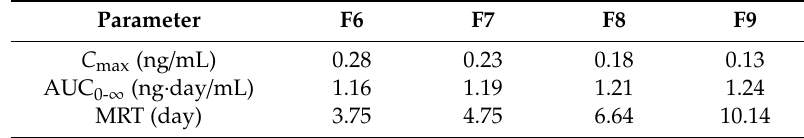
Table 5. Predicted pharmacokinetic parameters for the PLGA MS formulations